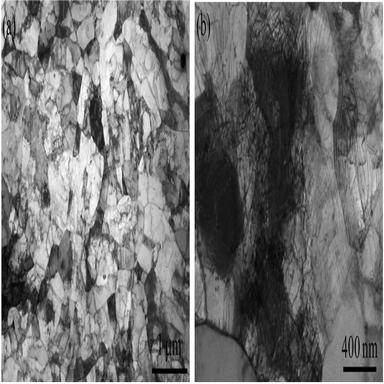
Microstructure of the novel carbide-free 9Cr-ODS steel after tempered at 750 ℃ by TEM in a relatively low magnification: (a) grain morphology, and (b) high density of dislocations.